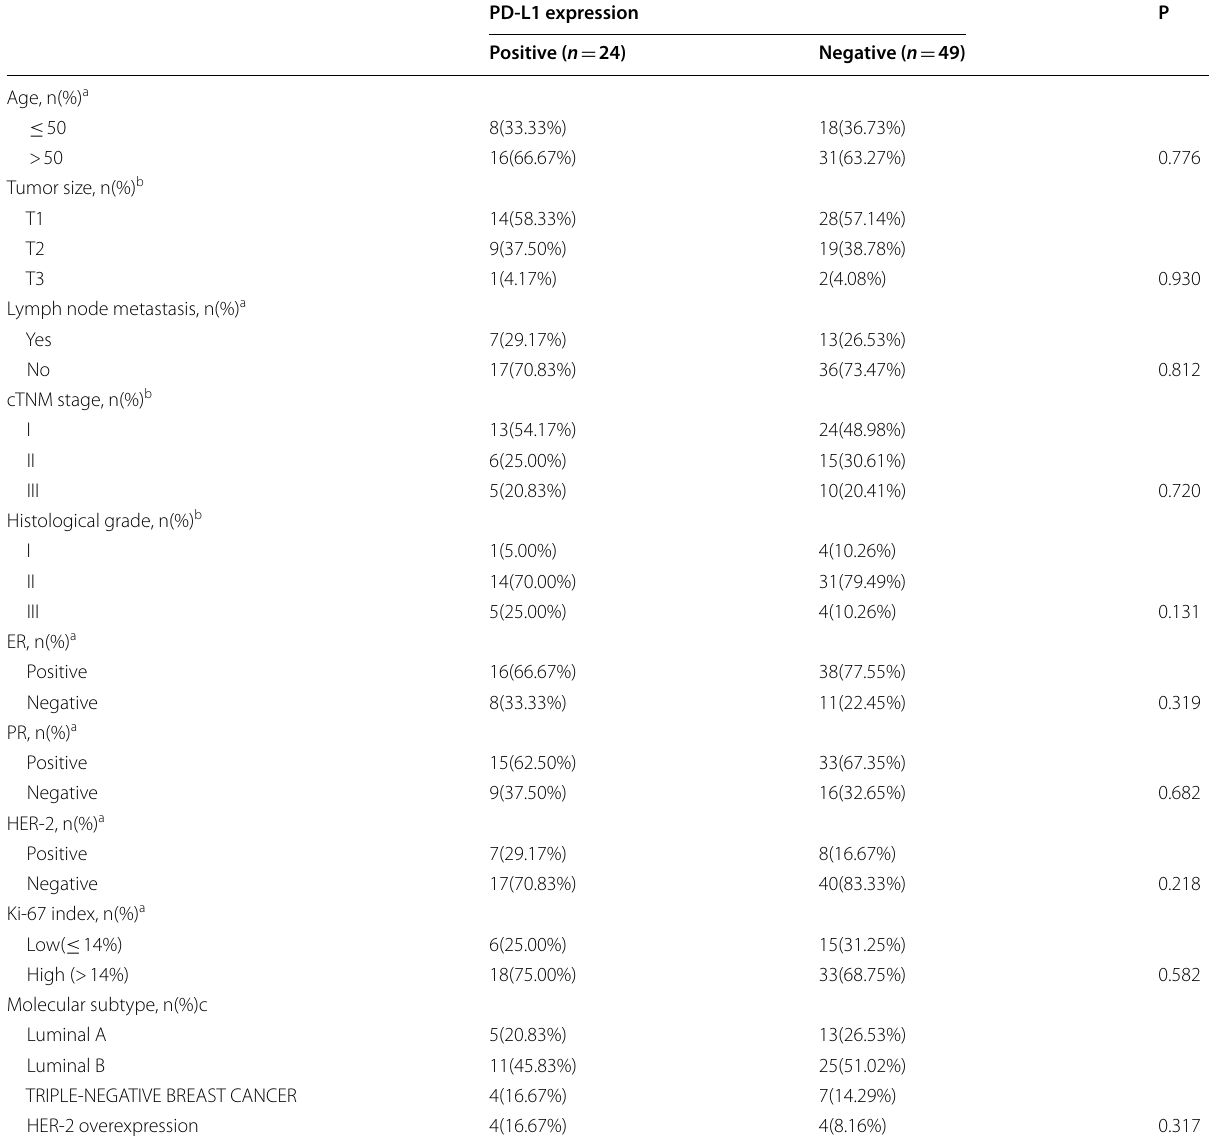
Table 2 The relationship between PD-L1 expression in TME and clinicopathological